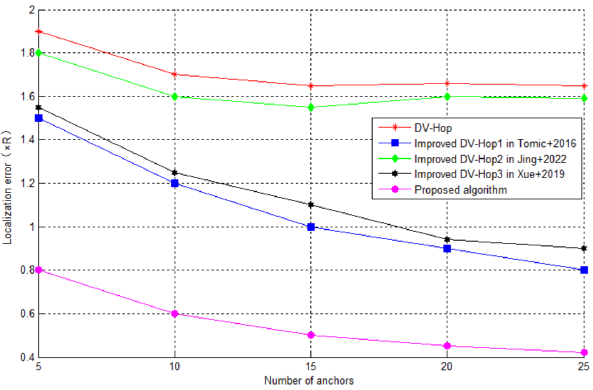
Electronics 2023 , 12 , x FOR PEER REVIEW Figure 10. Comparison of localization errors of different BNs [21][22][23]. Figure 10. Comparison of localization errors of different BNs [21–23].